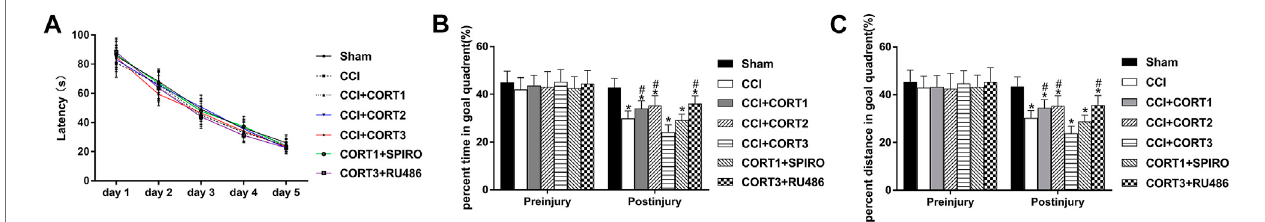
FIGURE1| Dose-dependenteffectsofCOR*TtreatmentsonspatialmemoryafterCCI. (A) Quanti fi cationoftheescapelatencyofratsduringtheMWMtestbefore CCI. (B, C) The percentage of time spent and distance travelled in the goal quadrant during the probe trial before and after CCI ( n (cid:1) 24 per group). * p < 0.05 versus the sham control group; # p < 0.05 versus the CCI control group. The data are presented as the means ±